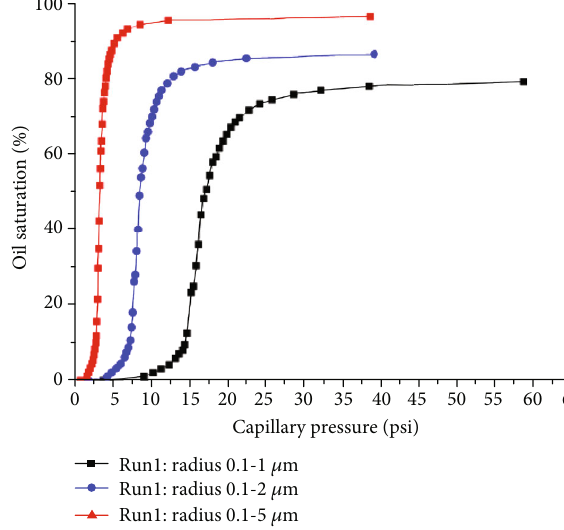
Figure 8: E ff ect of coordination number on oil charging